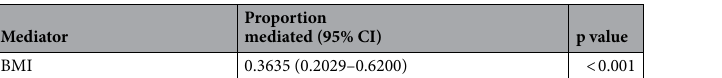
Table 5. Proportion mediated by body mass index in the association of greenness with diabetes. BMI body mass index, CI confidence